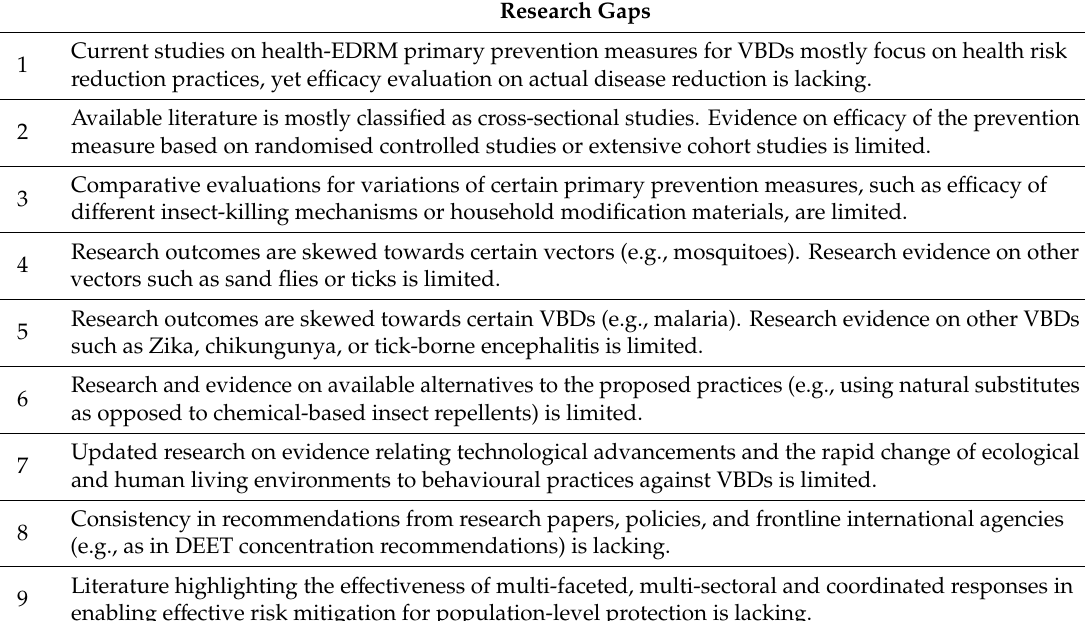
Table 6. Major Research Gaps in Current Published Literature Relating to Health-EDRM Primary Prevention Measures for